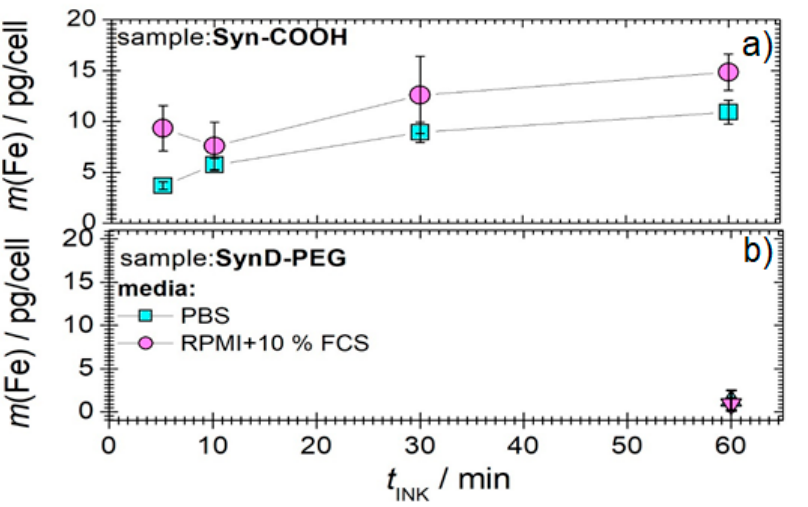
Figure 3. The iron mass per cell in 10 6 THP-1 monocytes determined with the spectrometer after the incubation times of 5, 10, 30, and 60 min for both MNP ( a ) Syn-COOH and ( b ) SynD-PEG in PBS and RPMI with 10% FCS. The uncertainty represents the standard deviation from three repeated measurements.